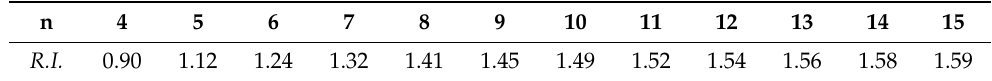
Table 2. Random consistency index.